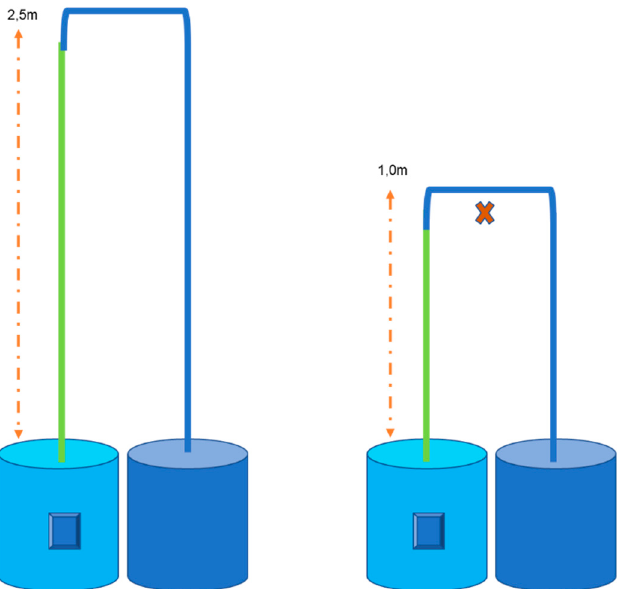
Figure 2. Tubing constructed representing the giraffe neck ( left ) and the ostrich neck ( right ) schematically, with the red cross indicating the brain.